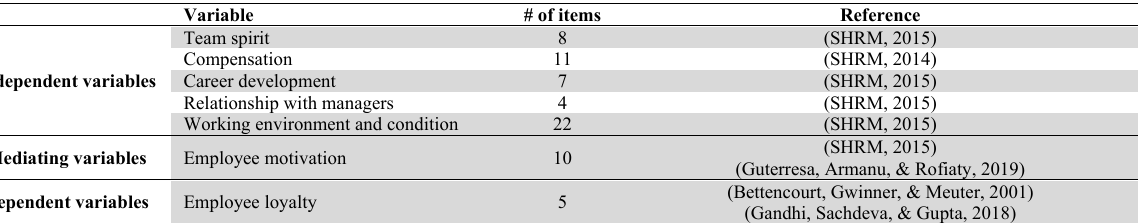
Measurement scales of variables